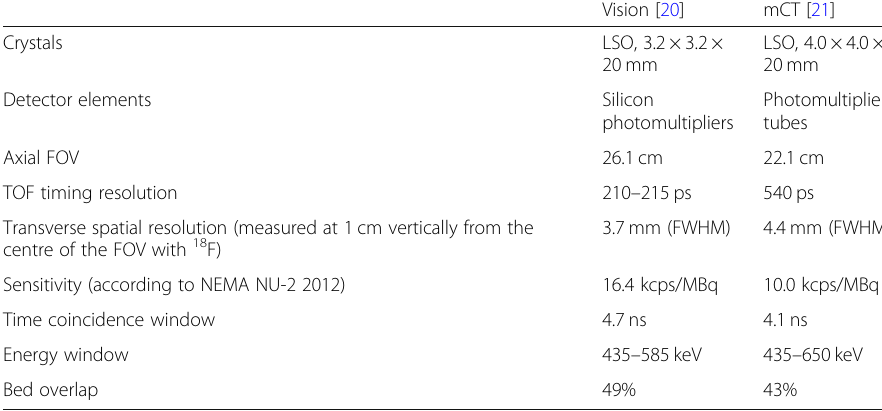
Table 1 Technical specifications of Biograph Vision and Biograph